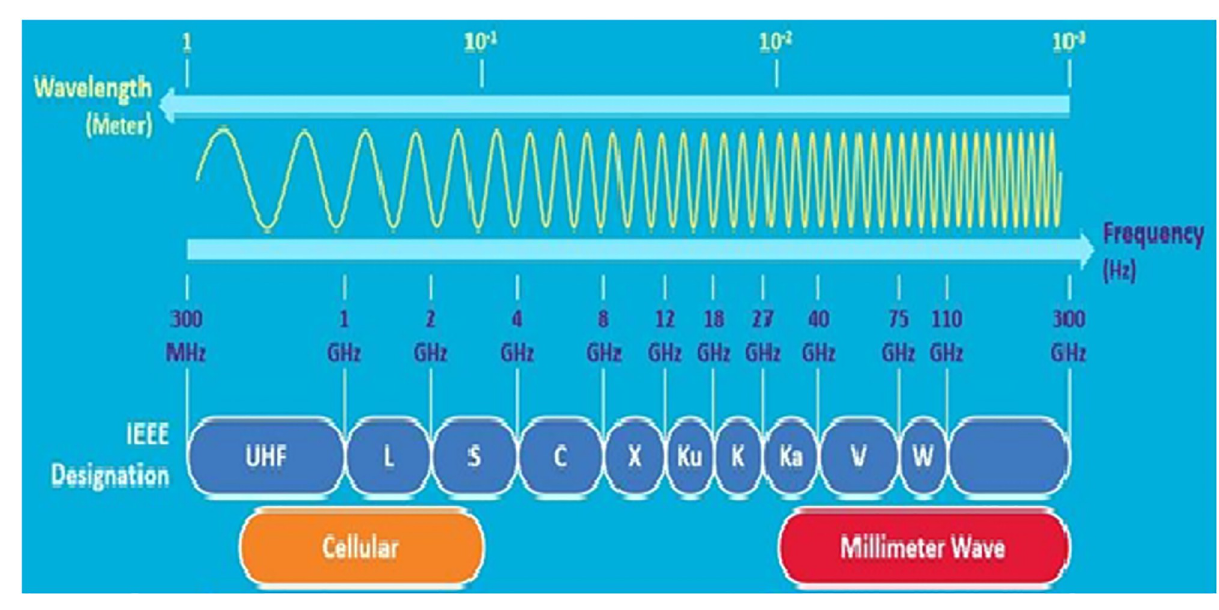
Fig 1. MmWave frequency spectrum band